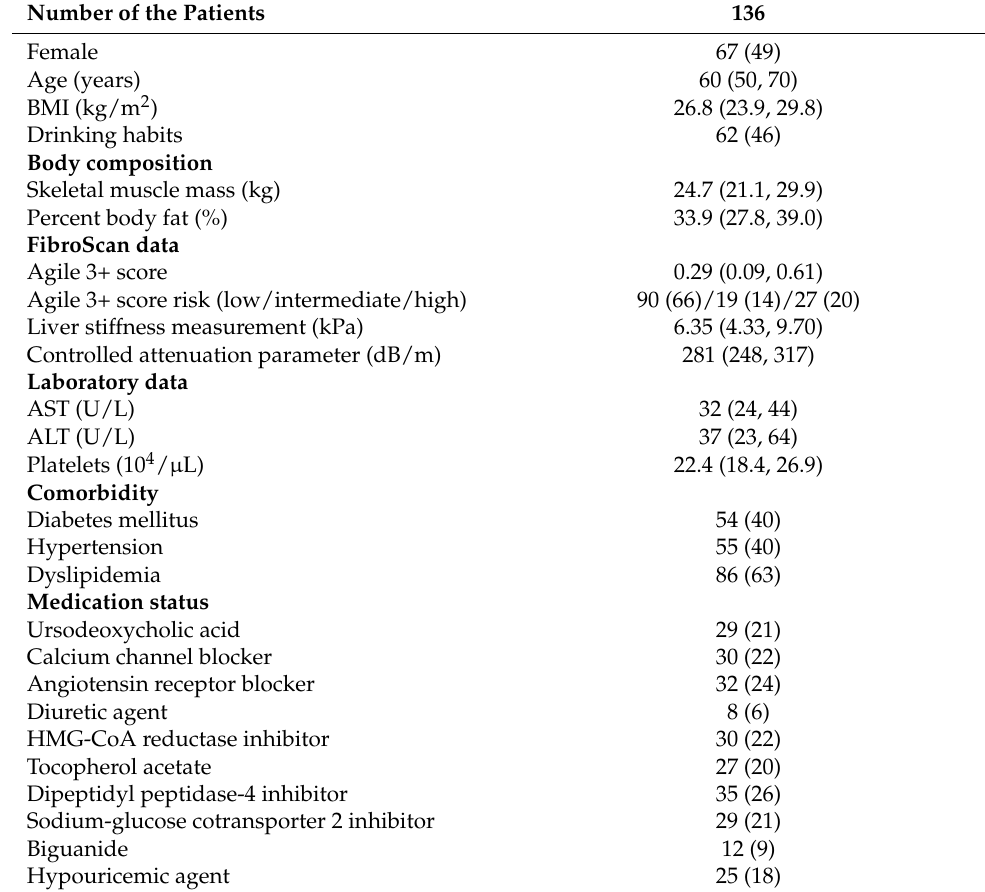
Table 1. Study subject characteristics and laboratory data related to liver status.